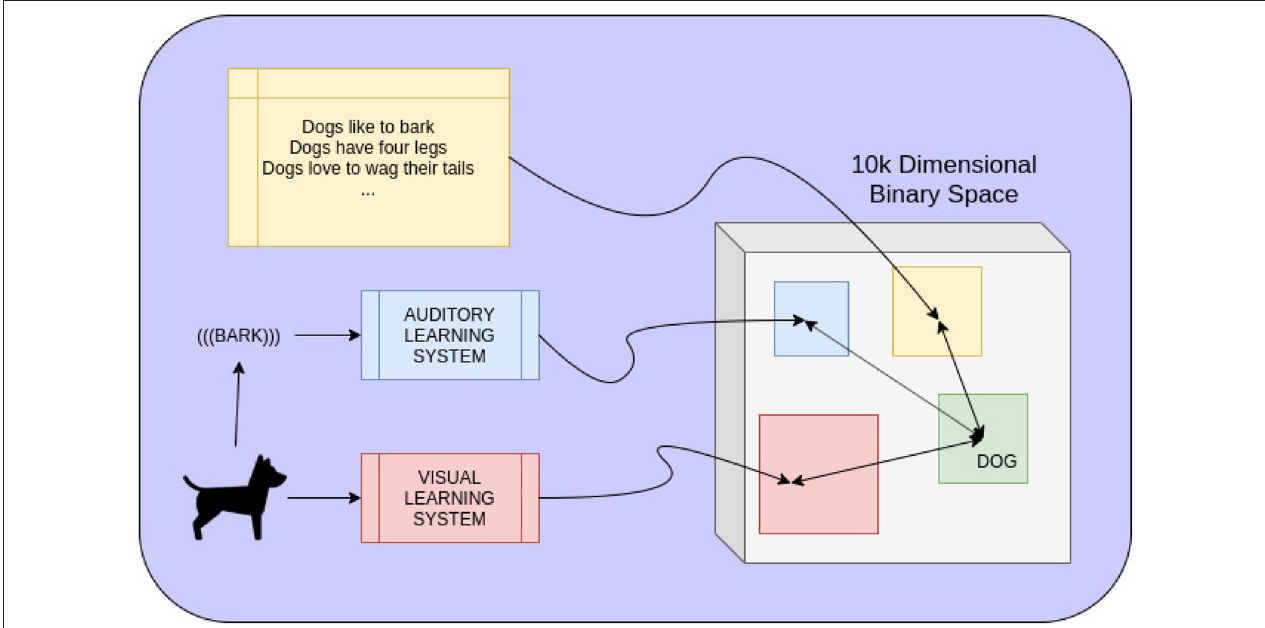
FIGURE 1 | Mapping different modalities of information to the same space of long binary vectors allows knowledge of the world to coexist and combine together symbolically as well. A dog may be seen and heard, recognized by two separate data-driven learning systems. The output of each, representing the presence of a dog, is mapped to a binary vector representing the current data. The closer this mapping is to a learned representation of all dogs, the more likely it is to be a dog. In the same space, linguistic knowledge of dogs can also be mapped to symbolic representations. Combining all three modalities by purely hyperdimensional computations gives a single symbolic representation of everything pertaining to the concept of